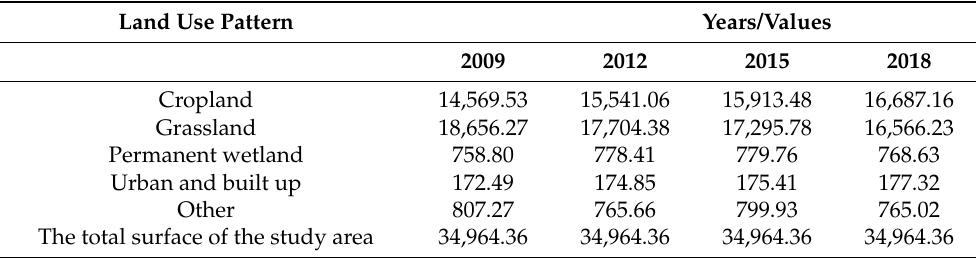
Table 2. The statistics of the land-use area in years 2009, 2012, 2015 and 2018 (km 2 ). Land Use